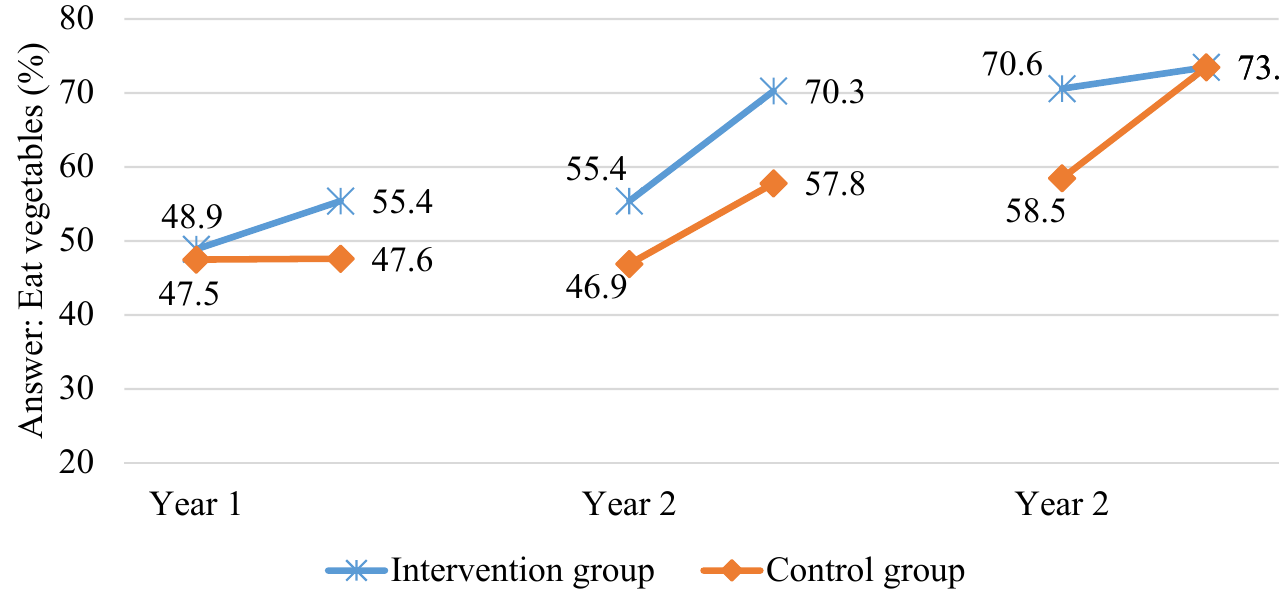
Figure 4. Proportion of children indicating vegetable consumption as a health-supporting behaviour during the three years of the study.